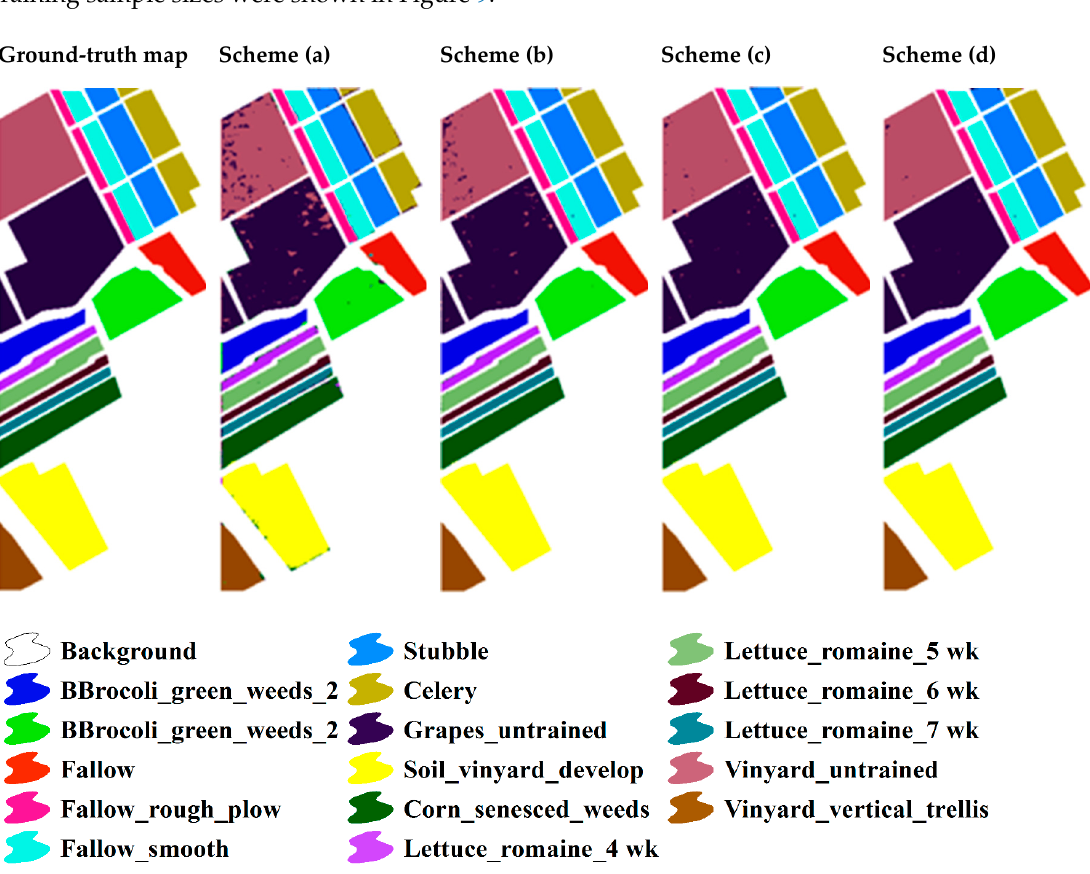
Table 5. User’s and Producer’s accuracy results (using 10% of the available training sample for the dataset), Overall accuracy and Cohen's Kappa of the HDCA with different schemes on the Salinas dataset.